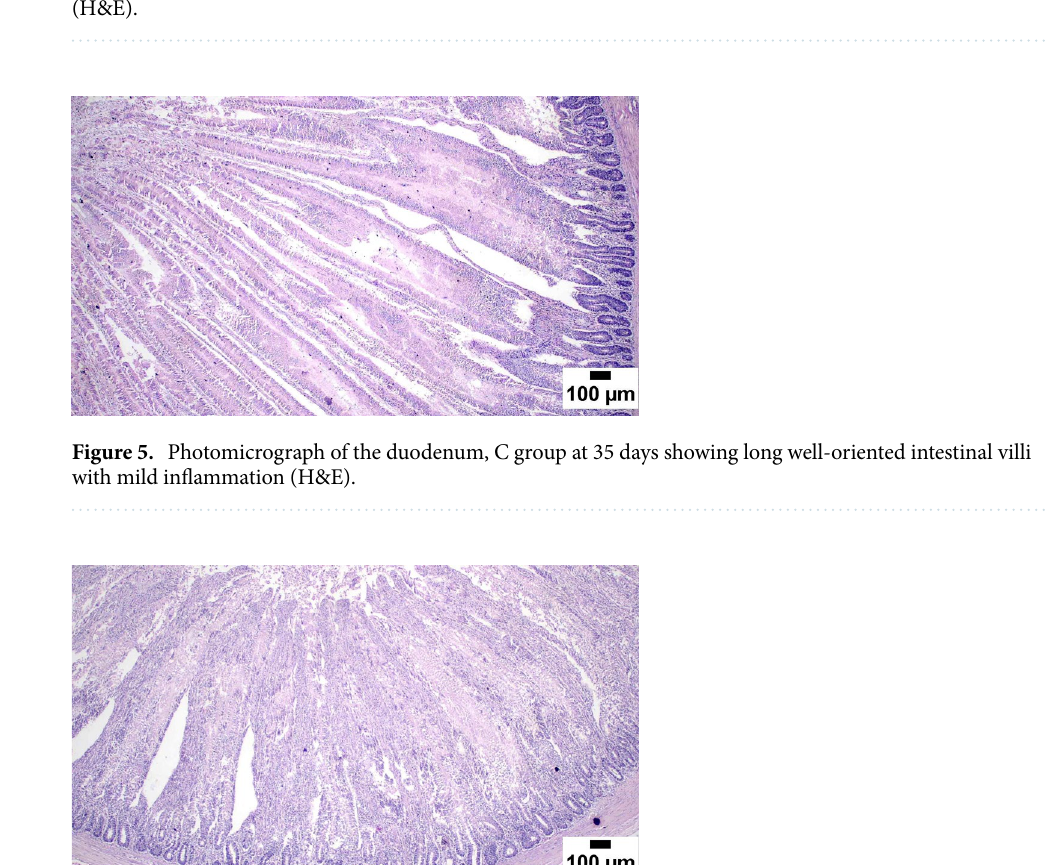
Figure 4. Photomicrograph of the duodenum, C group at 35 days showing ostensibly normal intestinal villi (H&E).